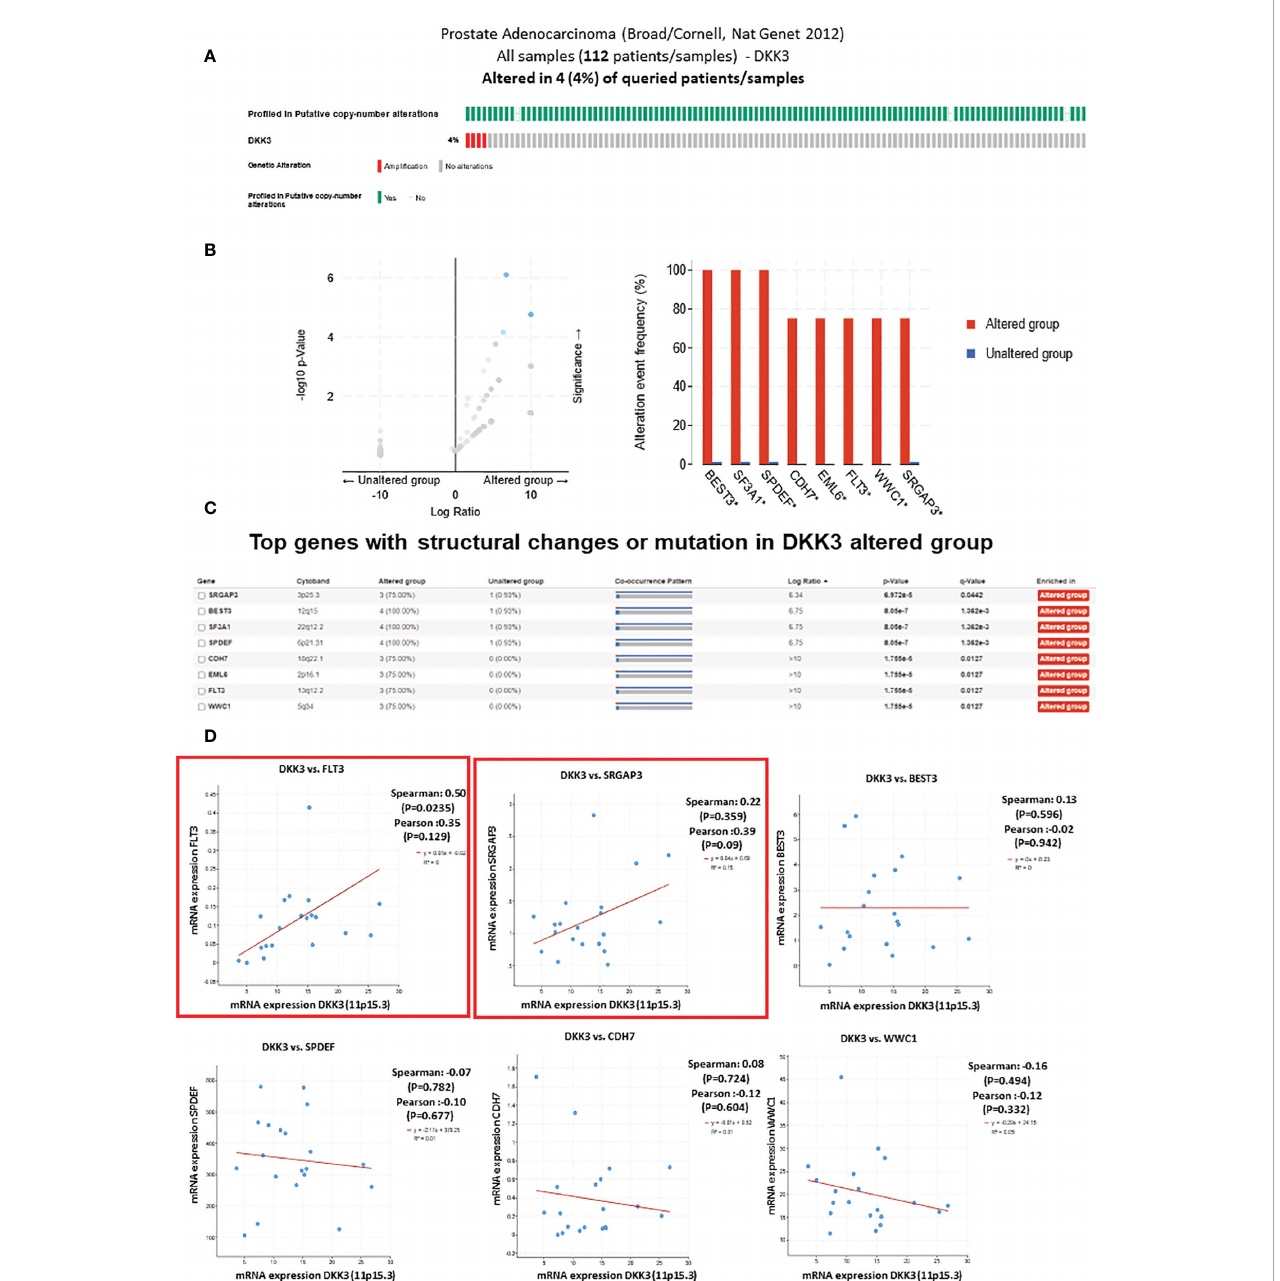
FIGURE 1 The genetic alterations of DKK3 and its correlation with other mutated genes in prostate adenocarcinoma samples obtained from TCGA, PanCancer Atlas database from cBioportal tool. (A) Oncoprint representation of alterations in DKK3 expression identi fi ed in Prostate Adenocarcinoma cohort (Broad/ Cornell, Nat Genet 2012) obtained from TCGA, PanCancer Atlas database from cBioportal tool. (B) Volcano plot of differentially expressed genes in DKK3 altered and unaltered group (left panel). Top genes with the highest alteration frequencies in DKK3 altered group (right panel). (C) List of the top genes with structural changes or mutation in DKK3 altered group. (D) The mRNA of DKK3 and its correlation with the identi fi ed top mutated genes in DKK3 altered